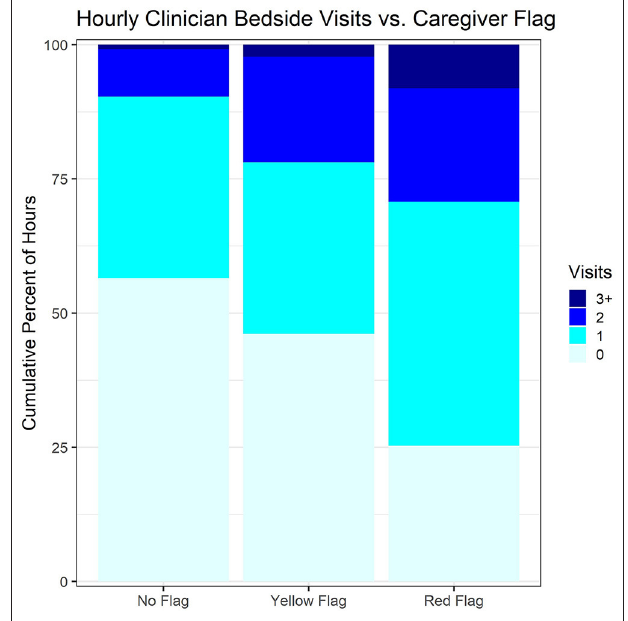
FIGURE 2 | Hourly clinician bedside visits vs. caregiver